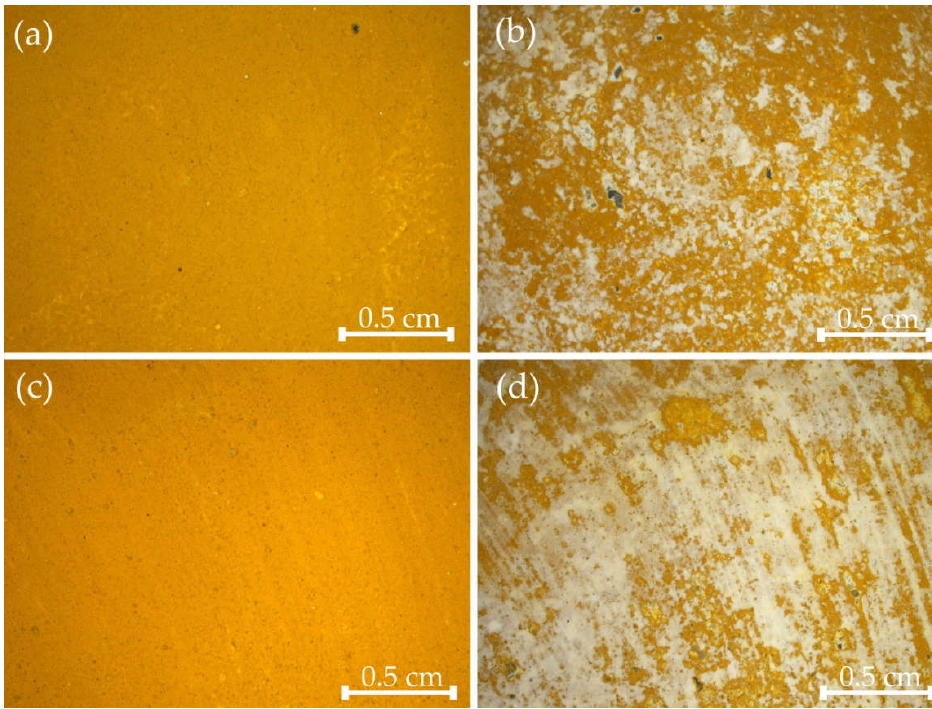
Figure 4. Detailed analysis of the pictorial layer by means of stereoscopic microscopy: ( a ) initial state of AC1; ( b ) state of AC1 after the cleaning; ( c ) initial state of AC2; ( d ) state of AC2 after the cleaning.